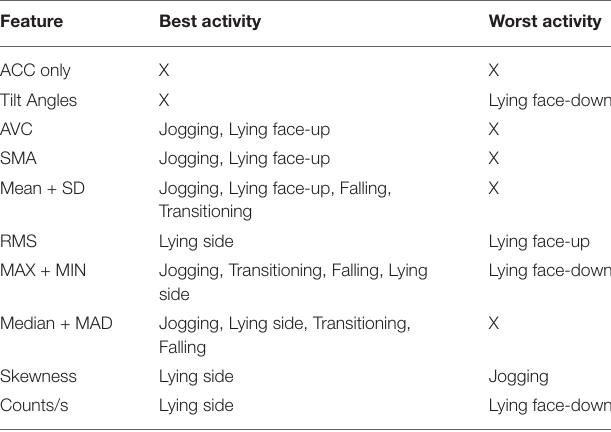
TABLE 4 | Best- and worst-case per feature accuracy using the features listed in the left column based on Table 3 .